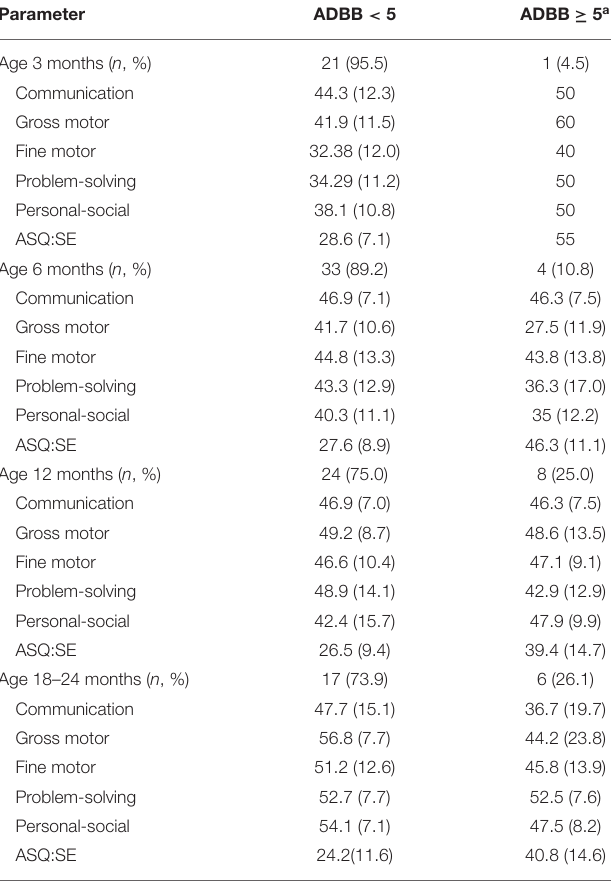
TABLE 2 | Distribution of the ASQ-3 ( N = 107) and ASQ:SE ( N = 114) domain score [shown as mean (SD)] by age and the ADBB score.